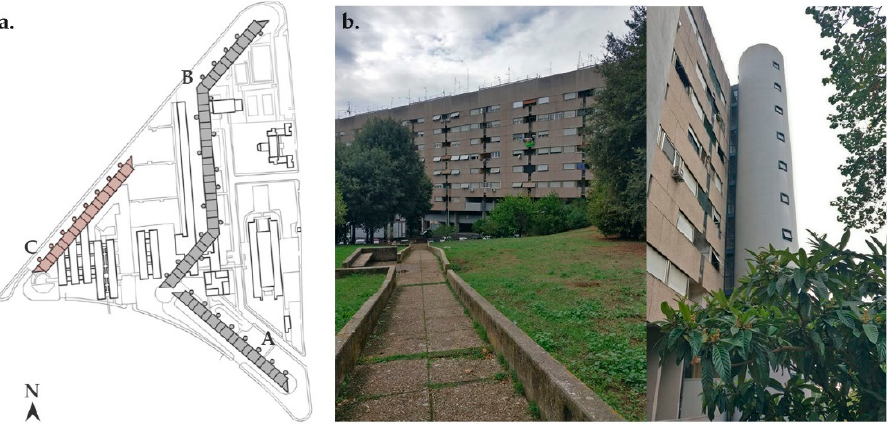
Figure 2. Case study building: site plan with building A, B and C ( a ); pictures of the facade and the cylindrical staircase volume of building C ( b ).